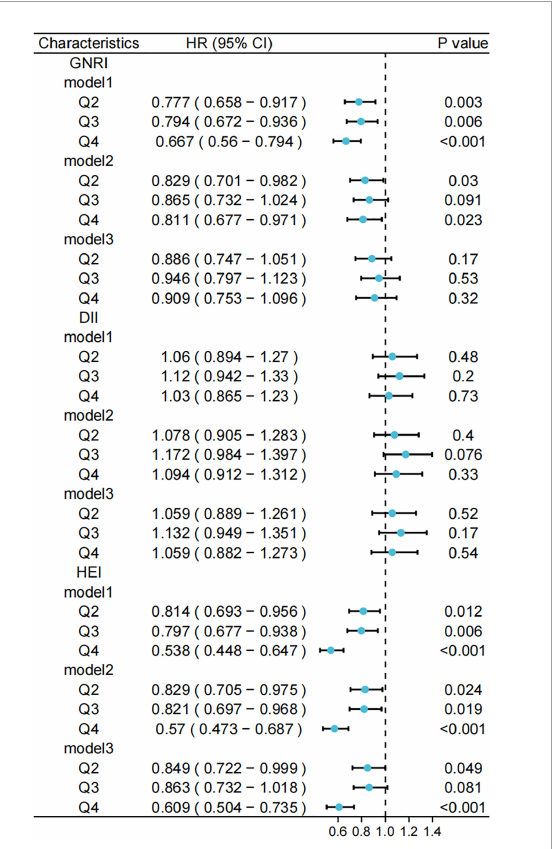
FIGURE5 Relationship between different scores and risk of cancer mortality. Standardized scores were divided into four groups (Q1, Q2, Q3, and Q4) according to the 25th, 50th, and 75th quartiles, with the Q1 group used as a reference. Model 1 was unadjusted for variables and Model 2 was adjusted for age, sex, race, marital status, and household income at baseline; Model 3 was further adjusted for history of hypertension, hyperlipidemia, and diabetes. GNRI, geriatric nutritional risk index; DII, dietary inflammatory index; HEI, healthy eating index.